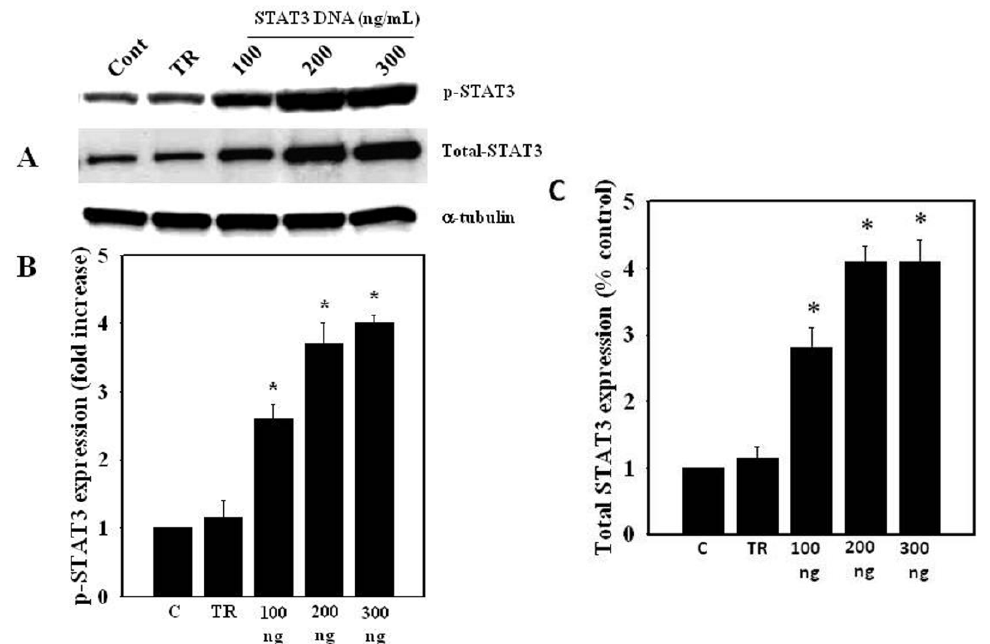
Figure 6. Total and phosphorylated STAT3 after astrocyte cultures were transfected with different concentrations of pExpress1-STAT3 (100–300 ng). ( A ) Western blots display a dose-dependent increase in total, as well as phosphorylated STAT3; ( B ) Quantification of STAT3 phosphorylation; ( C ) Quantification of total STAT3 protein expression. Data were subjected to ANOVA followed by Tukey‘s post hoc comparison test ( n = 3). * p < 0.05 vs. control. Error bars, mean ± S.E. C, control; TR, transfection reagent.